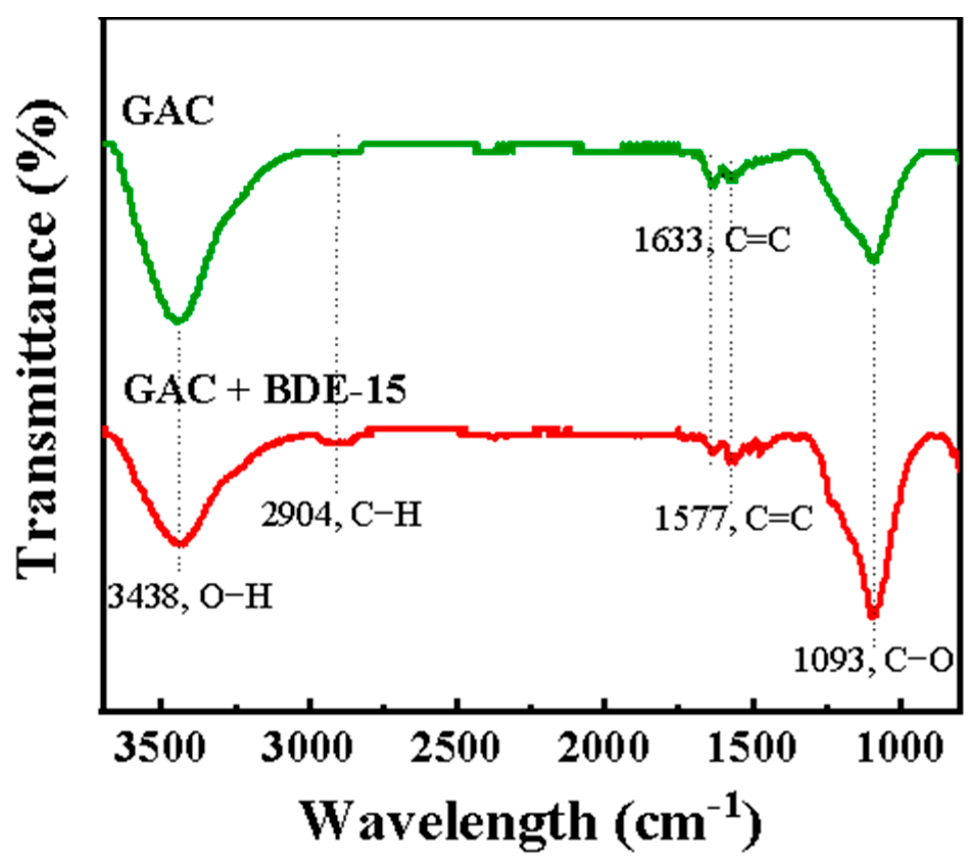
Figure 8. Infrared spectra before and after adsorption.